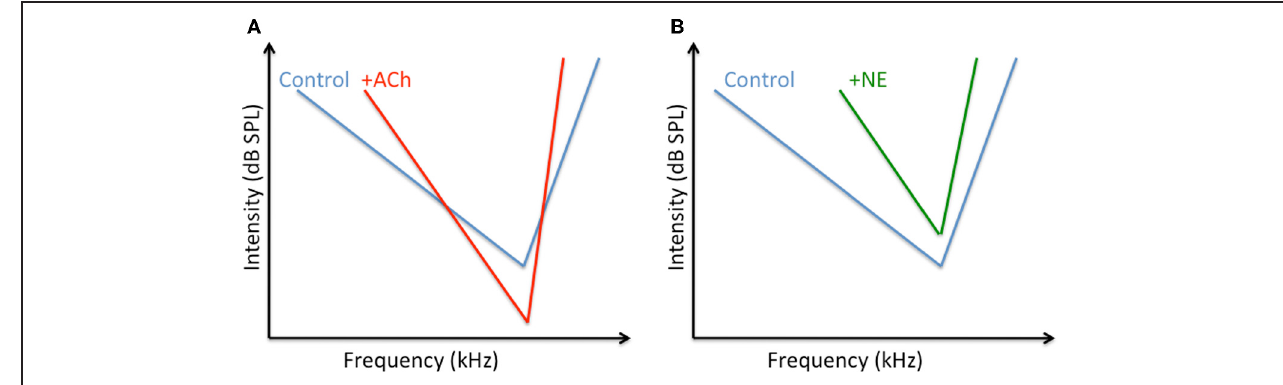
FIGURE 1 | Potential changes of ACh and NE on the tuning curve of auditory cortex neurons. (A) Converging results (Ashe et al., 1989; McKenna et al., 1989; Metherate et al., 1990; review in Metherate, 2011) indicate that ACh decrease the acoustic threshold at the CF and at surrounding frequencies whereas it should increase the threshold for frequency far away from the CF. These differential effects should